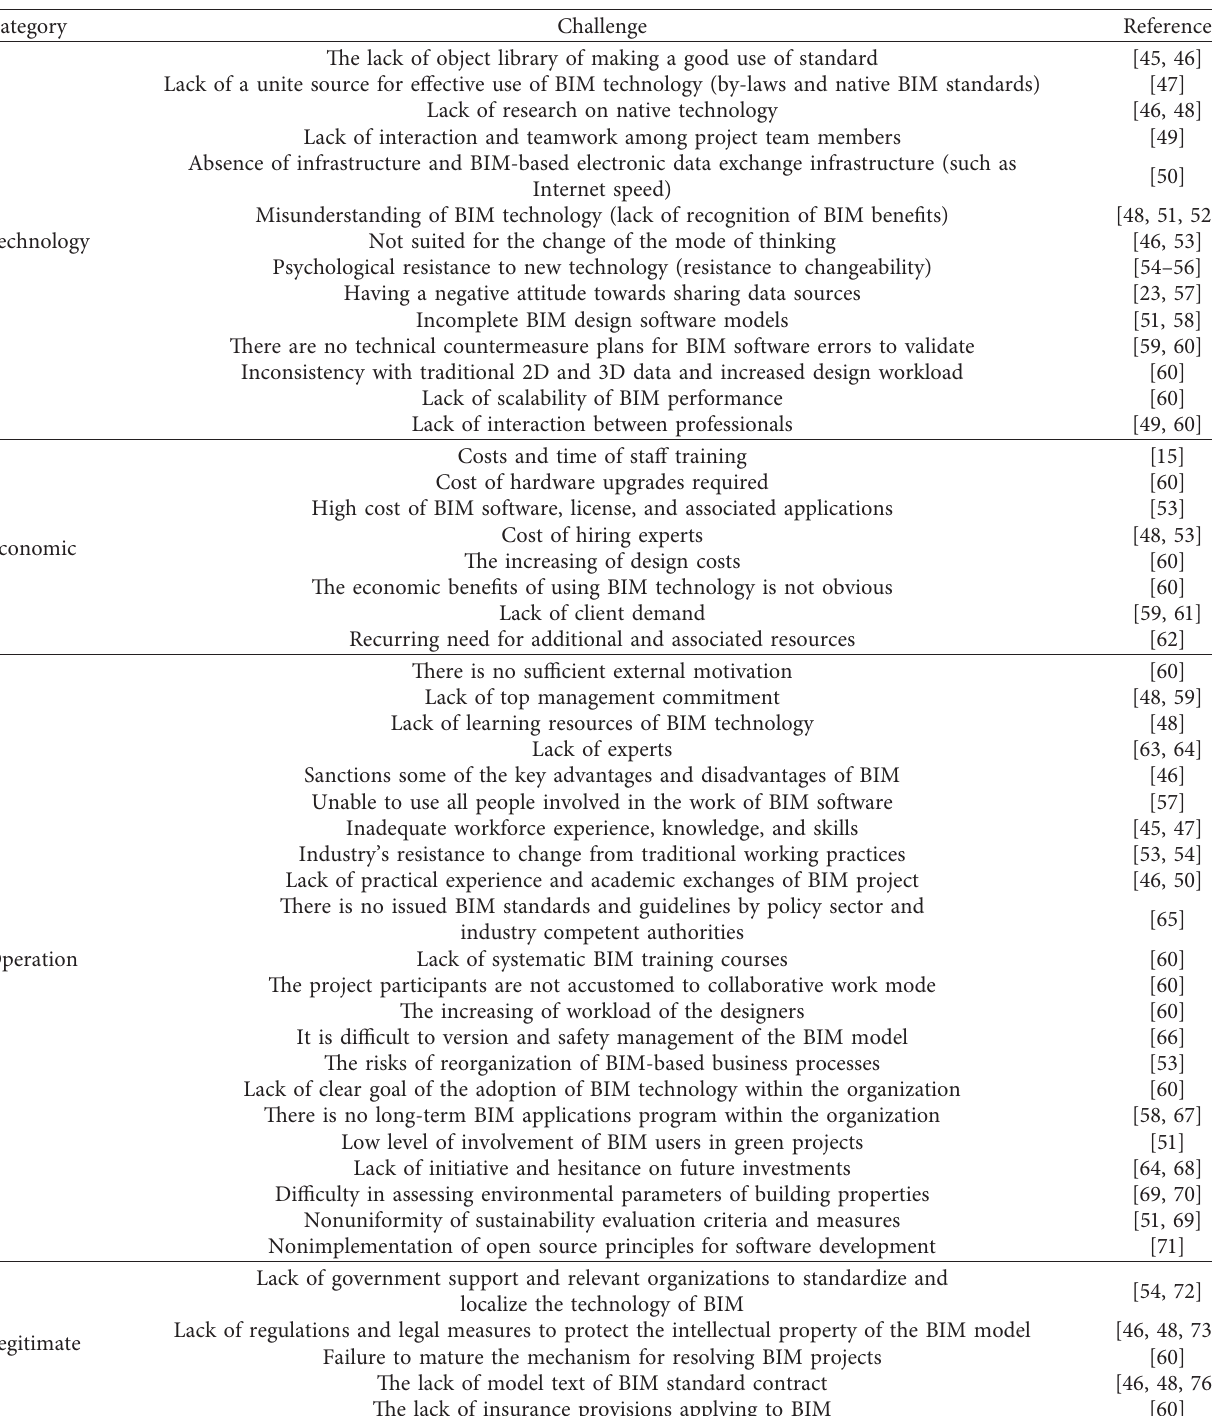
Table 1: Challenges found through BIM